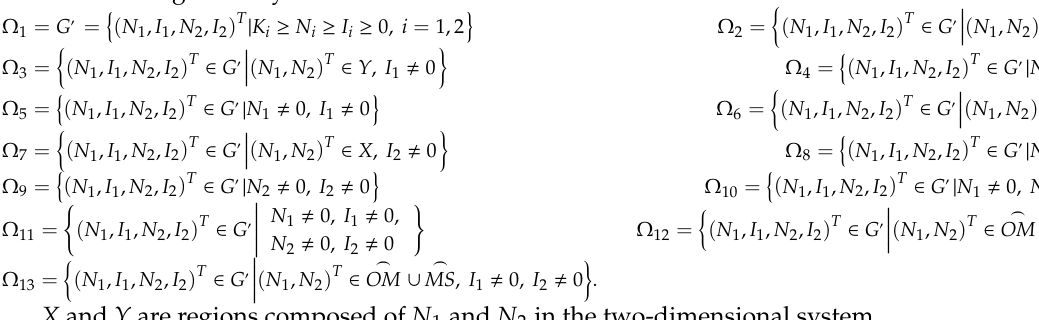
The meaning of the symbols in the